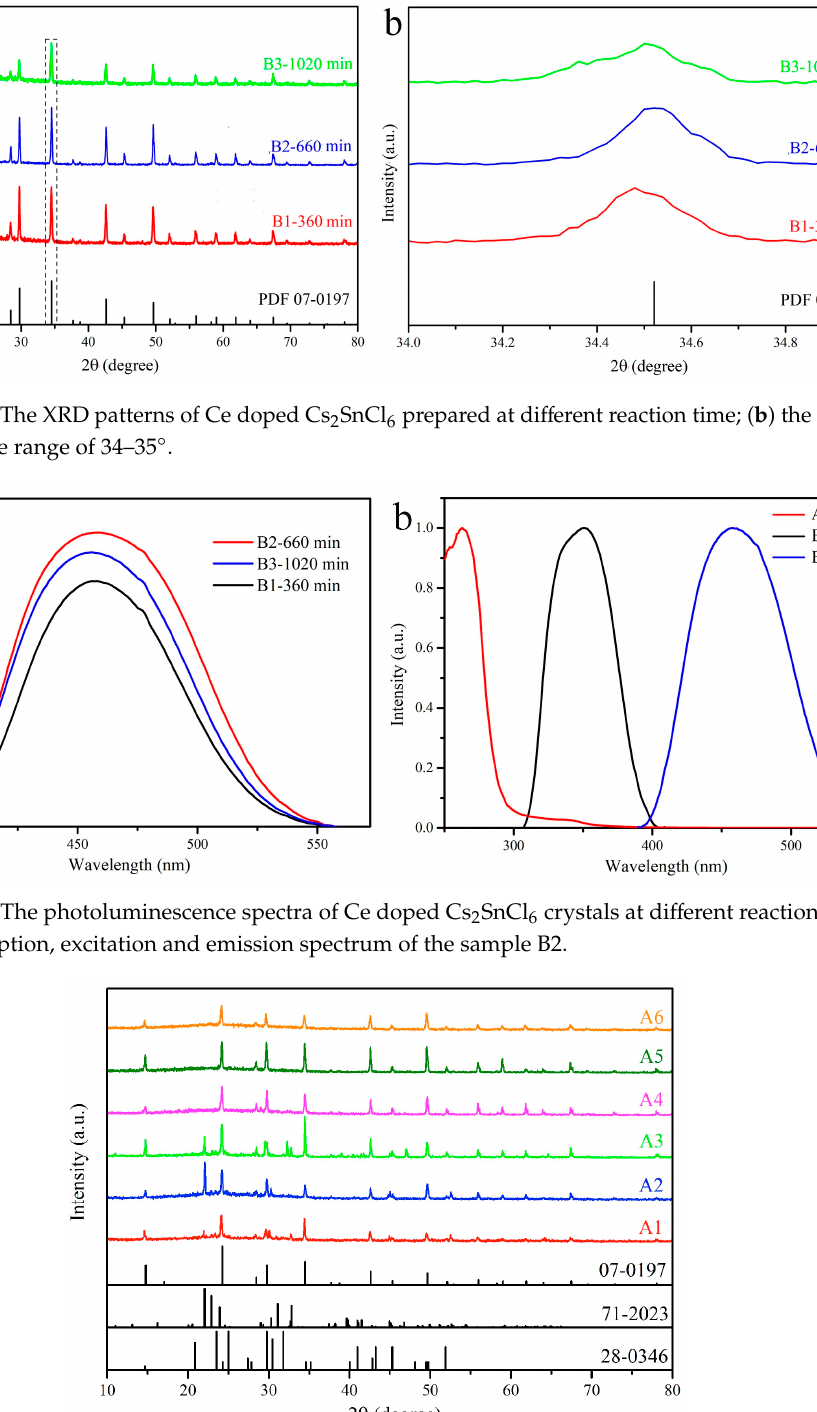
Figure 6. ( a ) The Cs 2 SnCl 6 crystal structure; ( b ) The Cs 2 SnCl 6 crystal structure containing [SnCl 6 ] 2 − ; ( c ) The Cs 2 SnCl 6 crystal structure containing [SnCl 6 ] 4 − and [CeCl 6 ] 3 − . Figure 7 is the PL spectra of Ce-doped samples at different concentrations. The undoped sample C1 show very low PL intensity. The intensity was enhanced with increasing the doping concentration and the C3 sample containing Ce 3+ (listed in Table 1) had the highest intensity. The measured fluorescence quantum efficiency of the C3 sample was 6.54% and the blue light can be observed under ultraviolet light irradiation (shown in the inset of Figure 7). Although the efficiency is much lower than that of Bi 3+ doped samples [29], as our best knowledge, this is the first report about the PL of the Cs 2 SnCl 6 crystal.